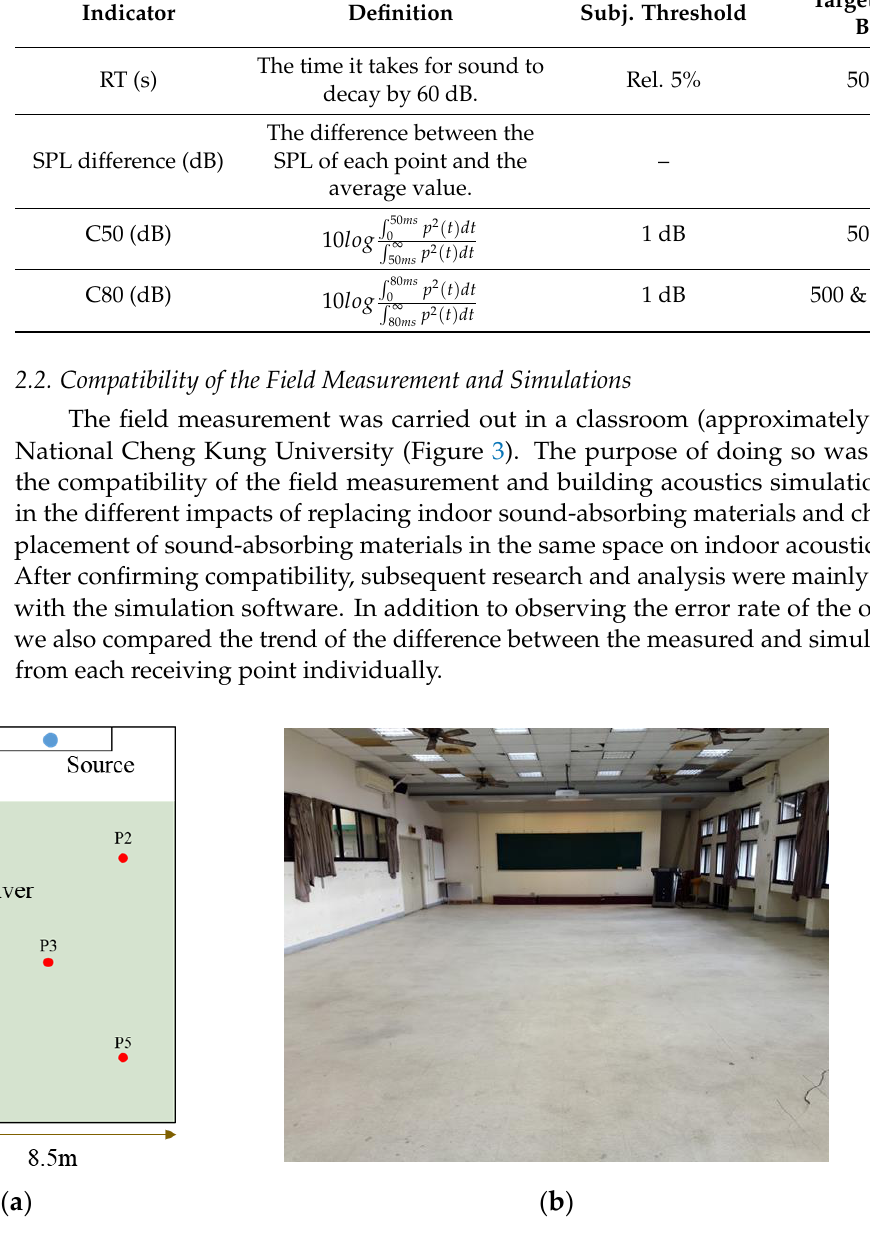
Figure 3. Space description of field measurement: ( a ) Space size; ( b ) Space photo. Table 1. Target indoor acoustic indicators.